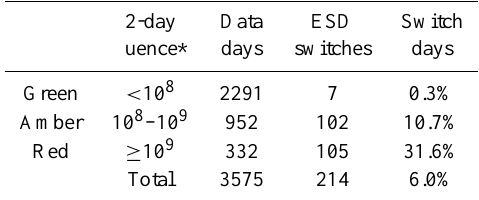
Table 1. Days with data and switches within the cycle [*